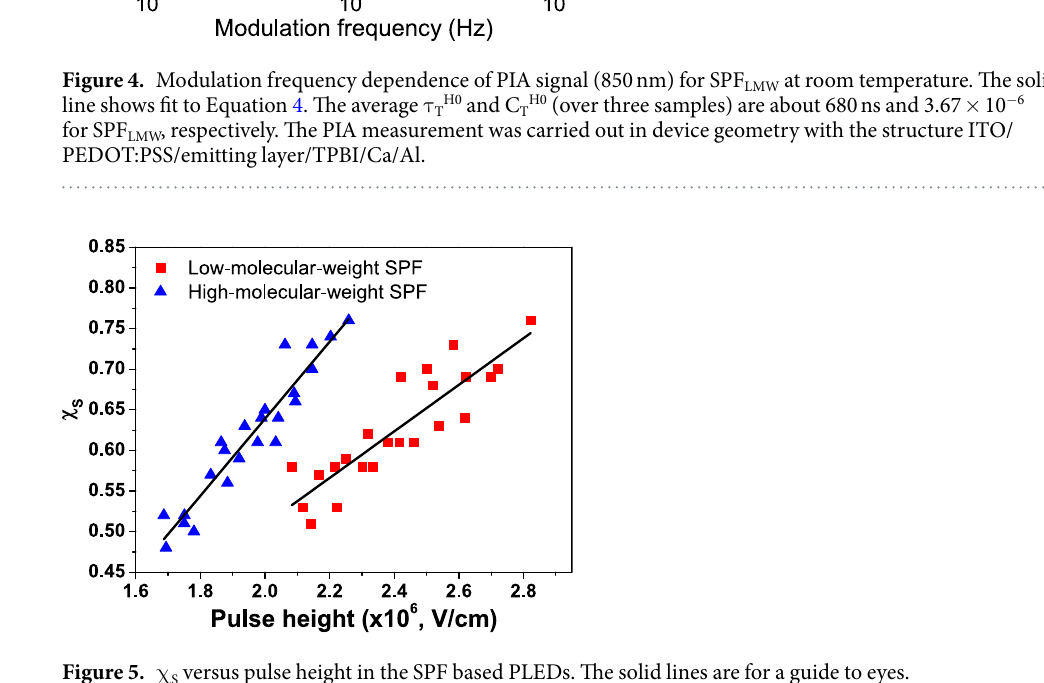
Figure 5. χ S versus pulse height in the SPF based PLEDs. The solid lines are for a guide to